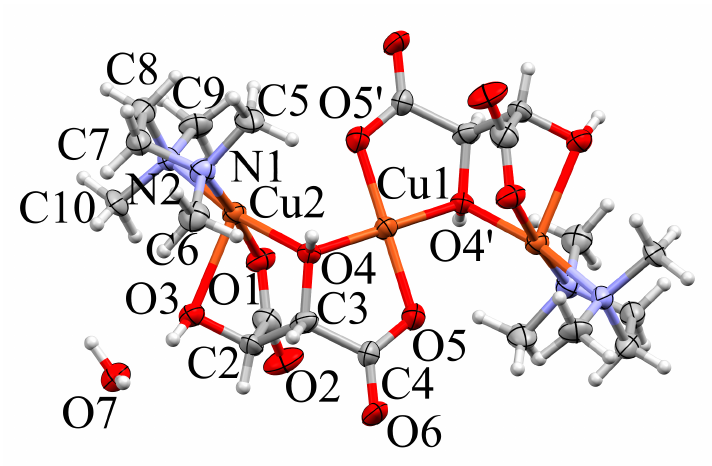
Figure 5. Trinuclear aggregate in the crystal structure of 2b (Mercury, [42]). Non-hydrogen atoms in the complex are shown as ellipsoids (70% probability), H as spheres with fixed radius of 0.15 Å. Coordination distances (Å): Cu1–O4 (cid:48) = 1.911(4), Cu1–O4 = 1.911(4), Cu1–O5 = 1.923(4), Cu1–O5 (cid:48) = 1.923(4), Cu1···O1 = 3.088(5), Cu1···O1 (cid:48) = 3.088(5), Cu2–O4 = 1.965(4), Cu2–O1 = 1.974(5), Cu2–N1 = 2.014(6), Cu2–N2 = 2.017(5), Cu2–O3 = 2.285(5), Cu2···O5 (cid:48) = 2.972(4).